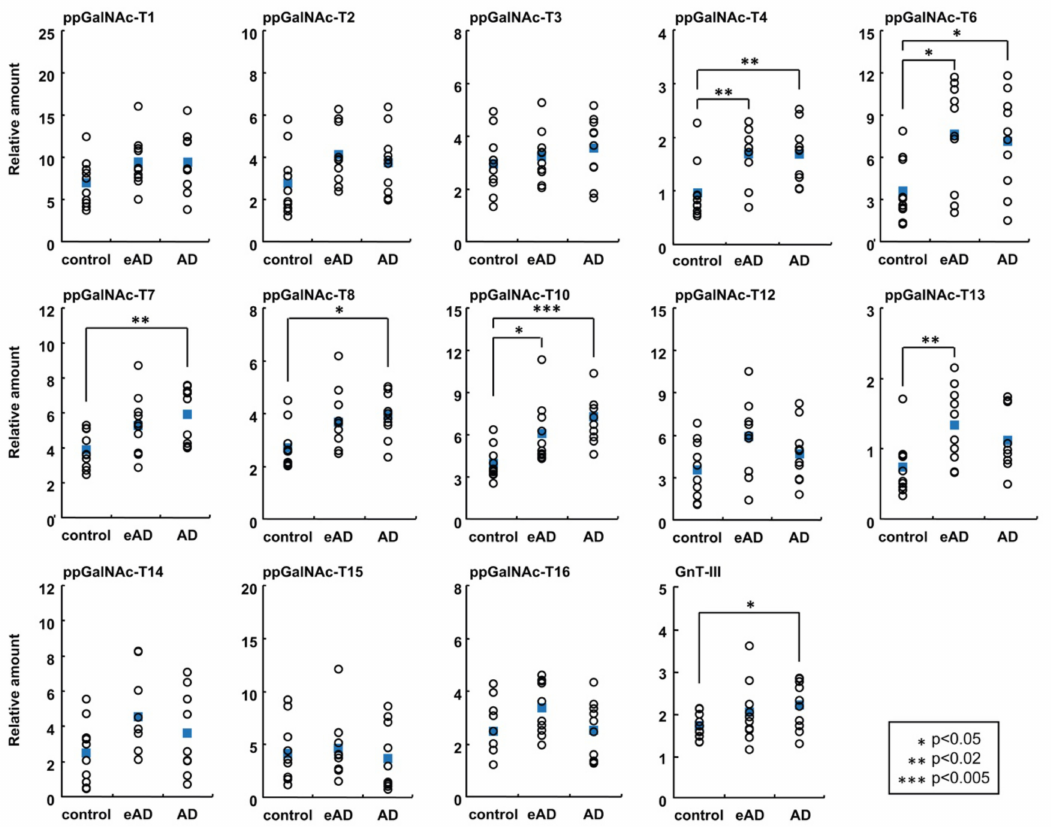
Figure 3. The expression of glycosyltransferases in AD brains by real-time PCR [67,75]. The results for isozymes in the ppGalNAc-T family and GnT-III are shown. Open circles indicate individual samples, and blue squares indicate average values for each group. eAD: early-stage